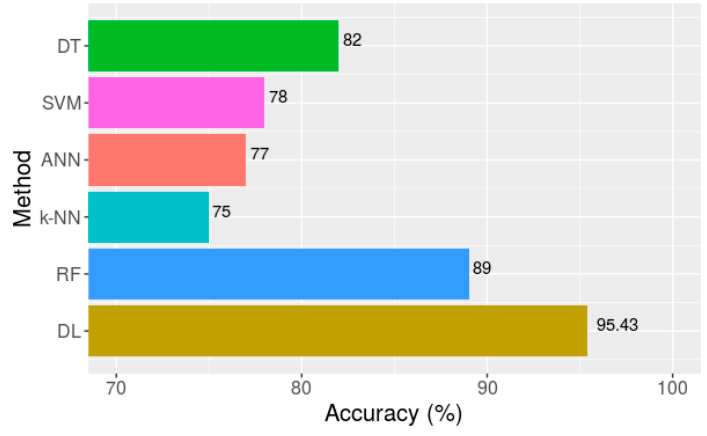
Figure 8. Accuracy of different classification methods.[8].